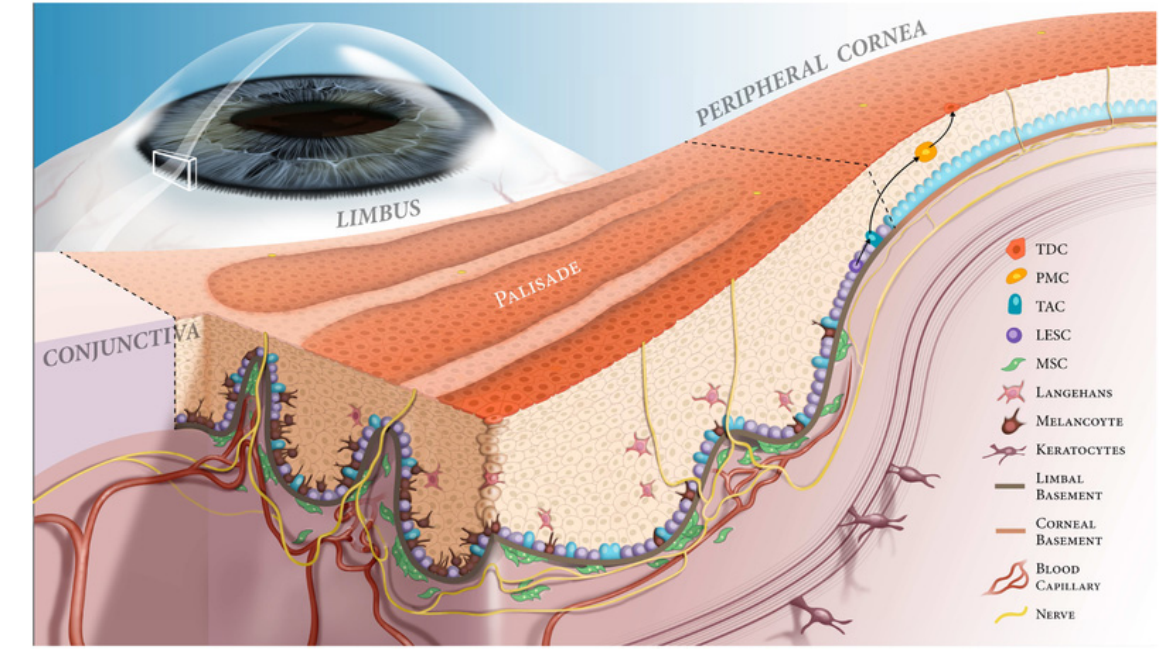
Figure 1. Schematic of the limbal niche. The corneoscleral limbus contains the Palisades of Vogt (PV) and limbal epithelial crypts. The limbal epithelial stem cells (LESCs) are in close contact with niche cells, including melanocytes and mesenchymal stem cells (MSCs) in the limbal epithelial crypts. The basement membranes of the cornea, limbus, and conjunctiva have different constructs, which are in turn necessary for maintaining proper homeostasis. In the basal epithelial layer of the limbal epithelial crypts, the LESCs divide symmetrically into two identical cells (in the horizontal plane) or asymmetrically to give rise to another LESC and a transient amplifying cell (TAC, in both vertical and horizontal planes). Then, TACs divide into postmitotic cells (PMCs) as they migrate centripetally. The PMCs then differentiate into terminally differentiated cells (TDCs) and are shed from the corneal surface.. Abbreviations: LESC, limbal epithelial stem cell, TAC, transient amplifying cell, PMC, post-mitotic cell, TDC, terminally differentiated cell, MSC, mesenchymal stem cell. Reproduced from [12]. Table 1. Putative markers of limbal stem cells.